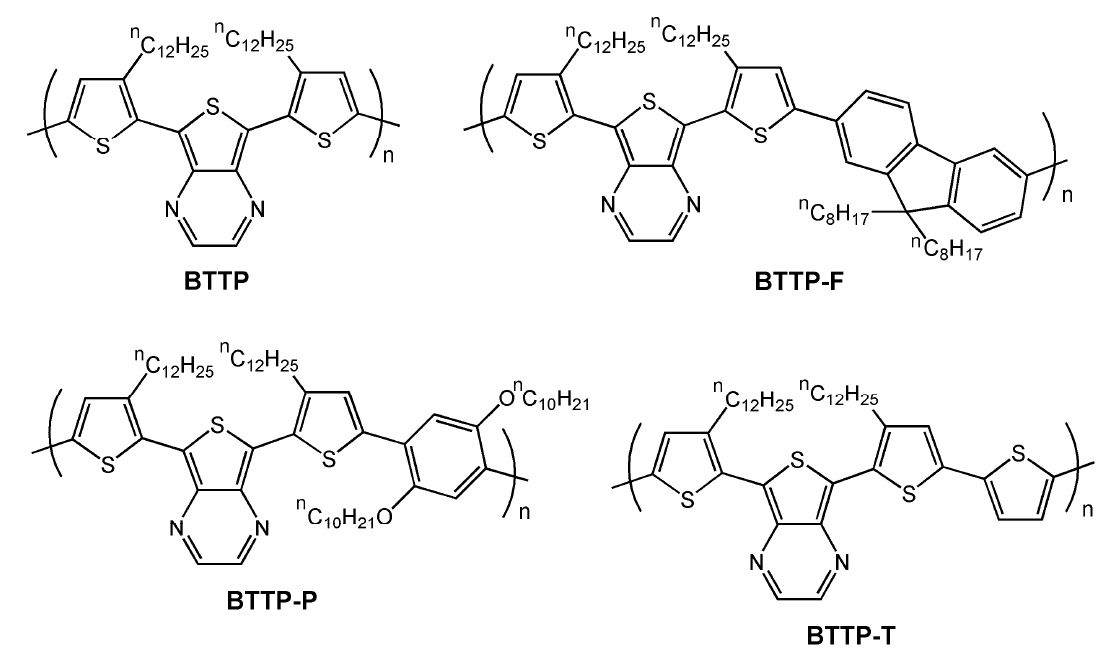
Figure 11. Chemical structures of the semiconducting copolymers BTTP , BTTP-F , BTTP-P , and BTTP-T .